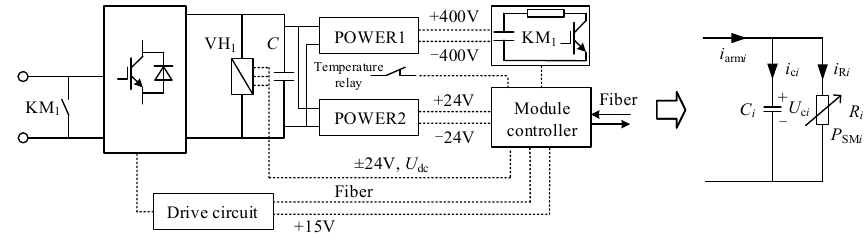
Figure 3. Real circuit topology of sub module (SM).